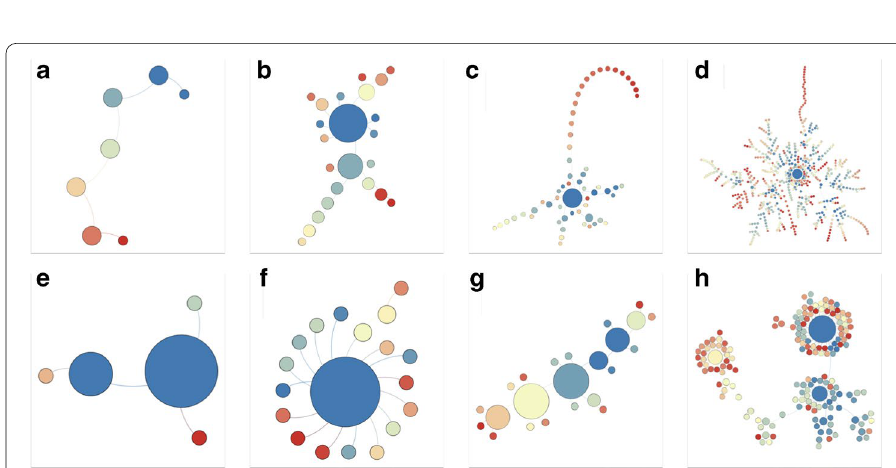
Fig. 2 A few example conversation trees from a–d Reddit and e–h Twitter. Each node represents a comment, retweet, or reply. Node size represents popularity (number of children) and node color represents temporal order in the tree sequence, from the root (blue) to the last leaf